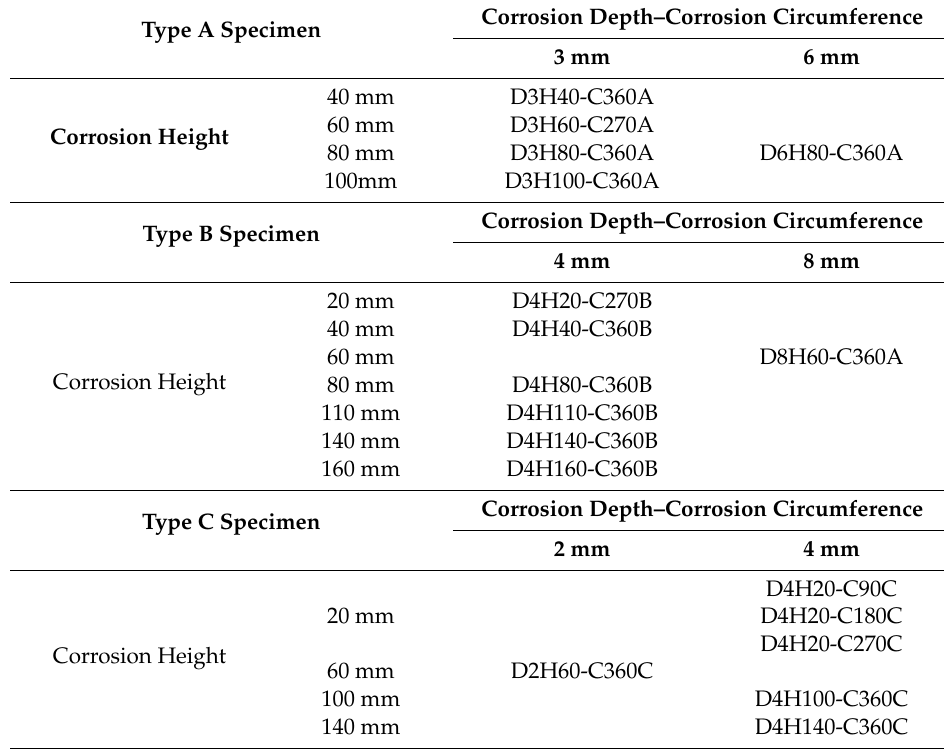
Table 3. Corrosion data of supplementary specimen.